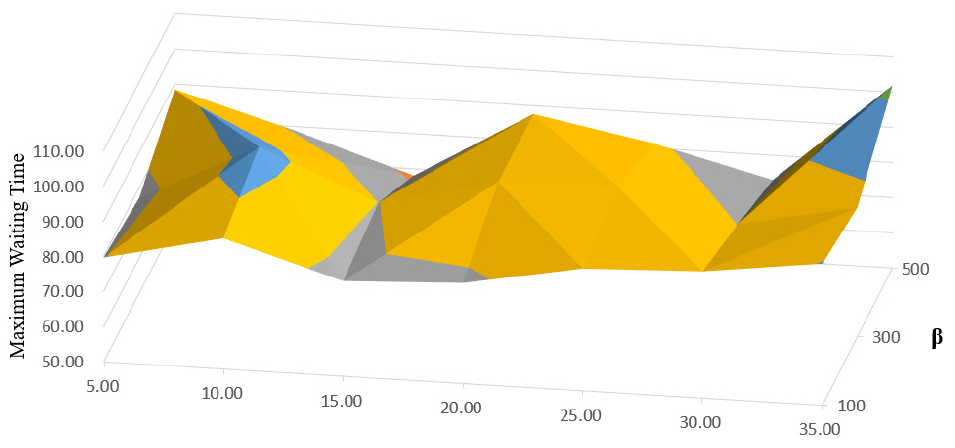
Figure 9. Maximum Wait Time difference with different α , β